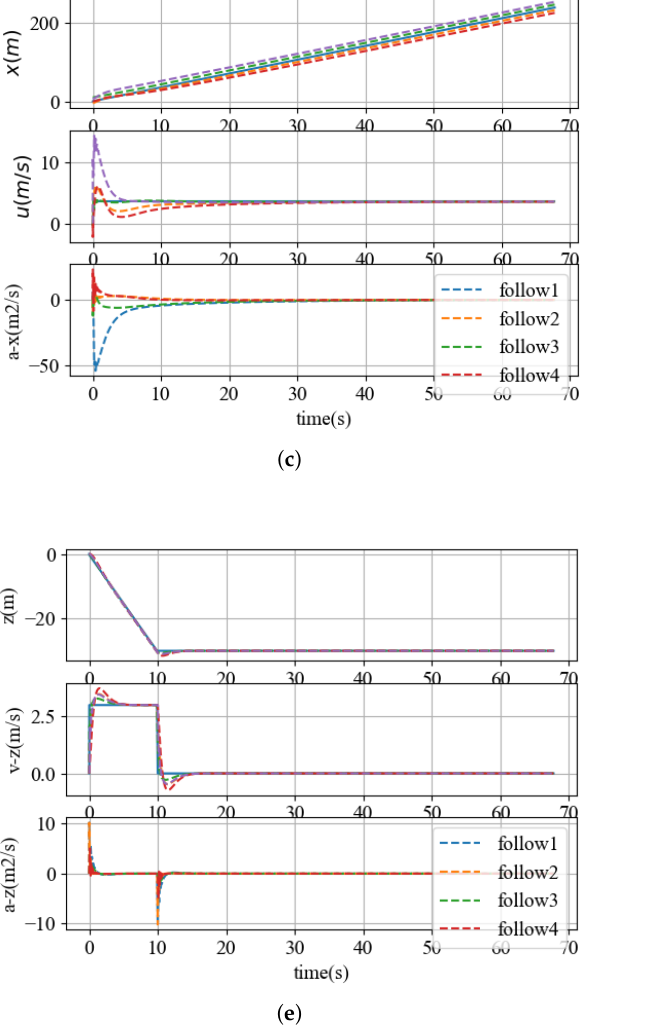
Figure 5. ( a ) HEAUVs’ formation (2-D); ( b ) HEAUVs’ formation (3-D); ( c ) state in x-direction (HEAUVs); ( d ) state in y-direction (HEAUVs); ( e ) state in z-direction (HEAUVs); ( f ) event trigger time